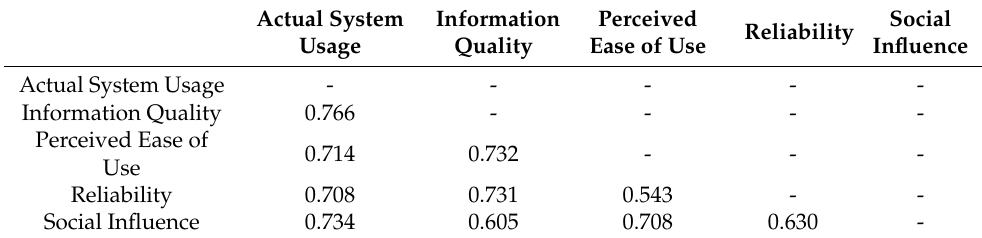
Table 4. Heterotrait–Monotrait Ratio.